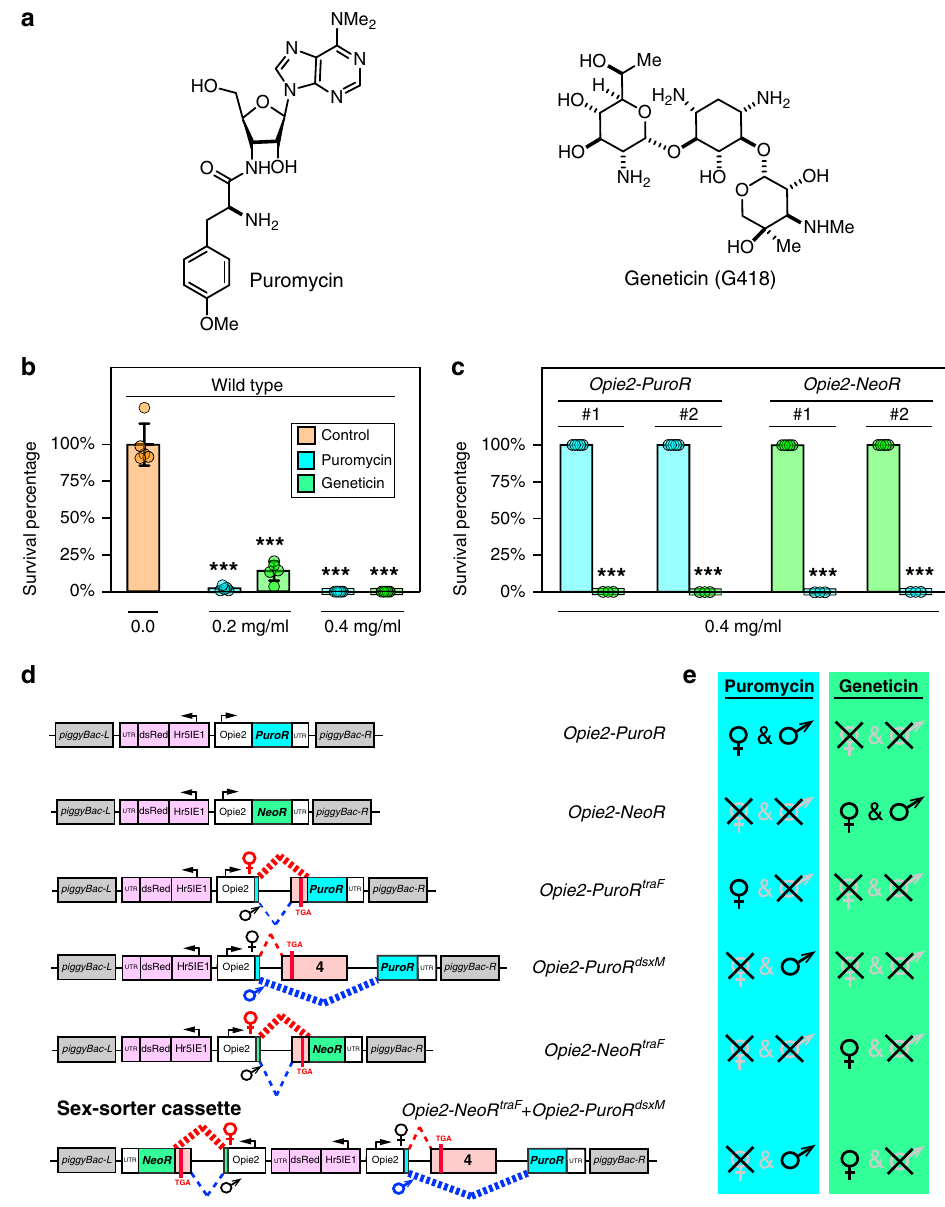
Fig. 1 Development of sex-sorter cassette in Drosophila . a Chemical structures of puromycin and geneticin (G418). b Supplementing fl y food with puromycin or geneticin to a fi nal concentration of 0.4 mg/ml completely arrests development of wildtype (wt) D. melanogaster . Both drugs are also toxic to wt larvae at 0.2 mg/ml, but a few adult fl ies do emerge. c Fly survival in two independent transgenic lines harboring one copy of either Opie2-PuroR or Opie2-NeoR mixed with wt fl ies on food supplemented with 0.4 mg/mL of puromycin or geneticin. The PuroR and NeoR genes expressed under the